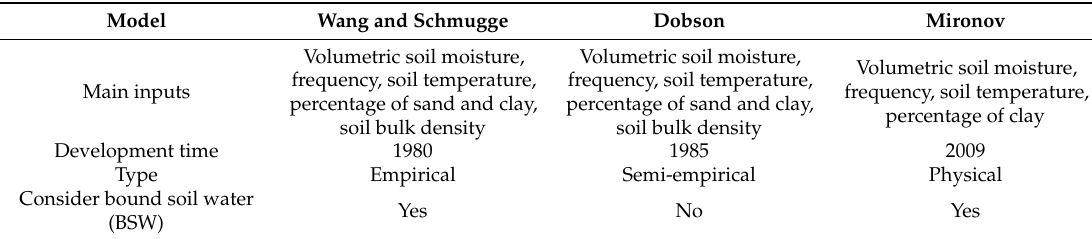
Table 5. Basic information of the three soil dielectric mixing models.